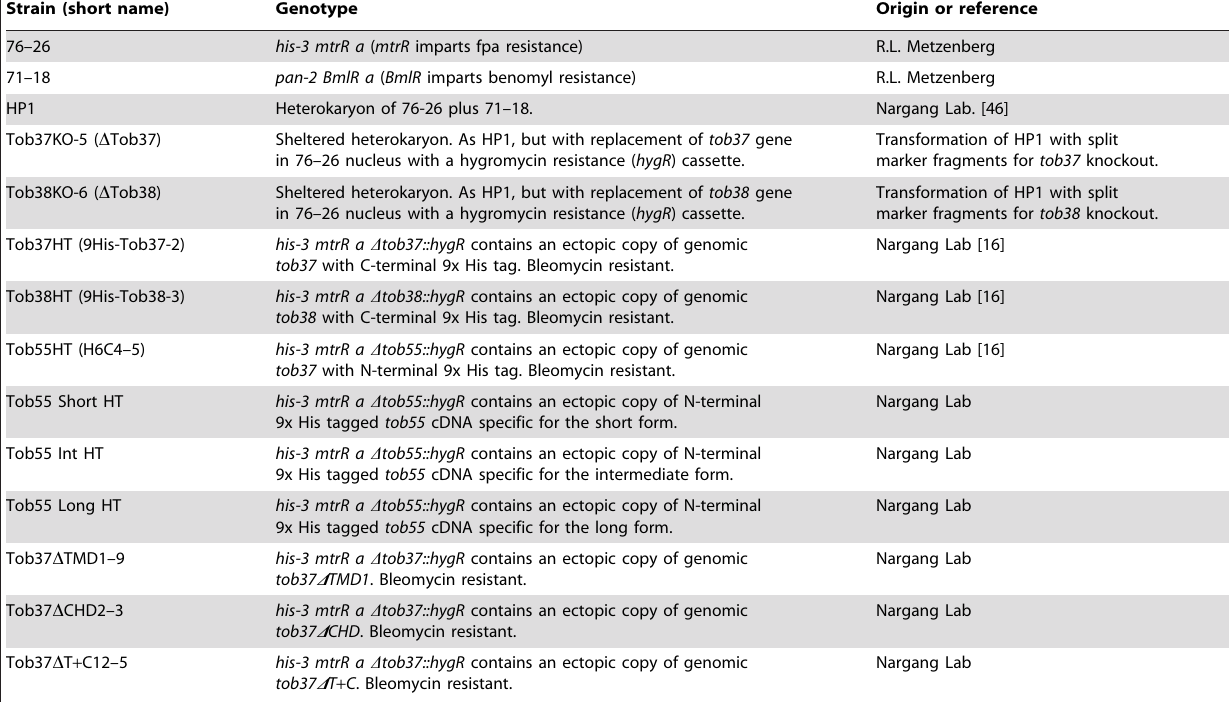
Table 1 . Strains used in this